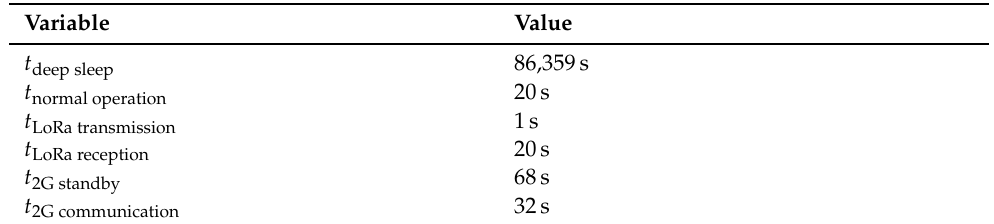
Table A2. Time duration in each phase on a daily basis for the